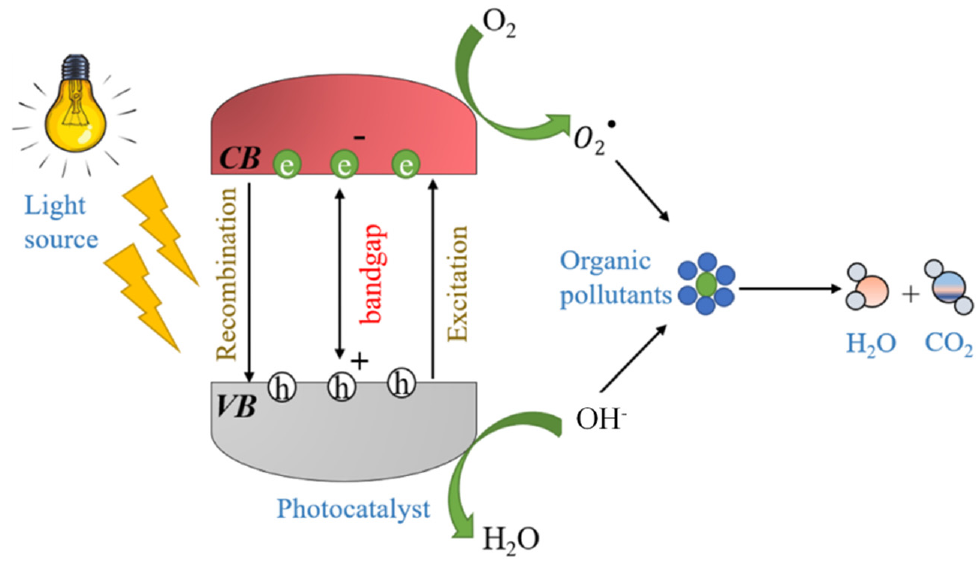
Figure 2. Schematic diagram of the photocatalytic degradation process.